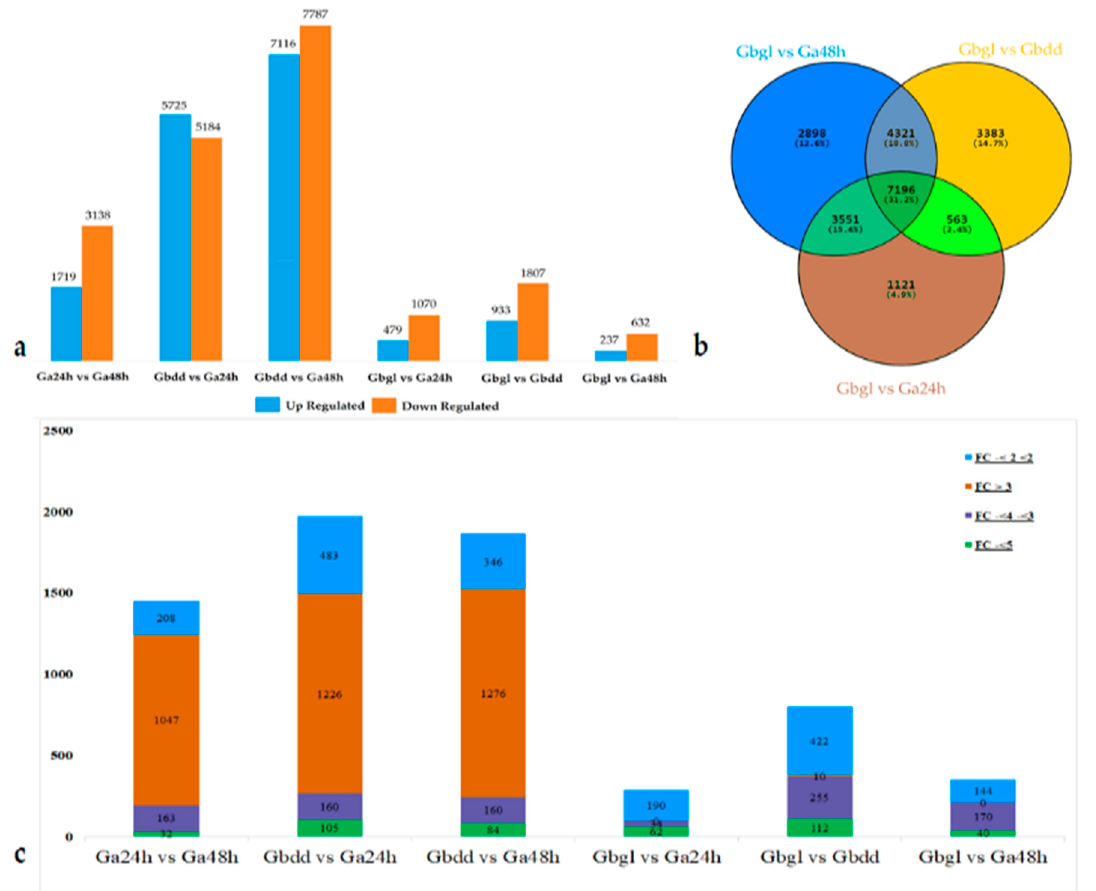
Figure 3. Expression dynamics changes and comparative analysis of differentially-expressed genes (DEGs) between Gbgl, Ga24h, Gbdd and Ga48h following delayed gland morphogenesis at imbibed seed and seedling stages. ( a ) Number of DEGs showing the up-regulated and down-regulated genes; ( b ) Venn diagram showing common genes, all differentially-expressed genes in different stages; ( c ) the number of transcripts demonstrating changes in expression in Gbgl, Ga24h, Gbdd and Ga24h following pattern fold change (FC) in expression, calculated as the log2 ratio of gene expression in glandless imbibed seed with glanded imbibed seed and seedling. Gbdd, Ga24h, Gbgl and Ga48h represent G. bickii glanded seedlings, G. arboreum glanded imbibed seeds, G. bickii glandless imbibed seeds and G. arboreum glanded seedlings, respectively.